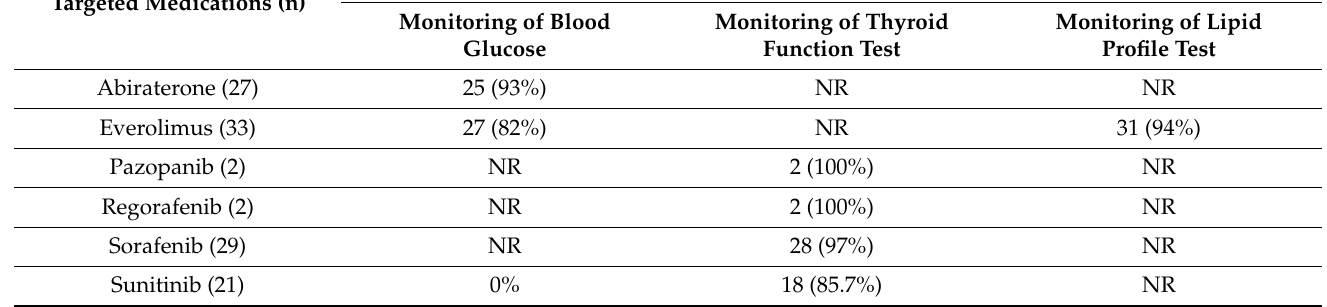
Table 3. Prevalence of Monitoring Errors of Endocrinopathies in Patients Receiving Oral Targeted Chemotherapy.